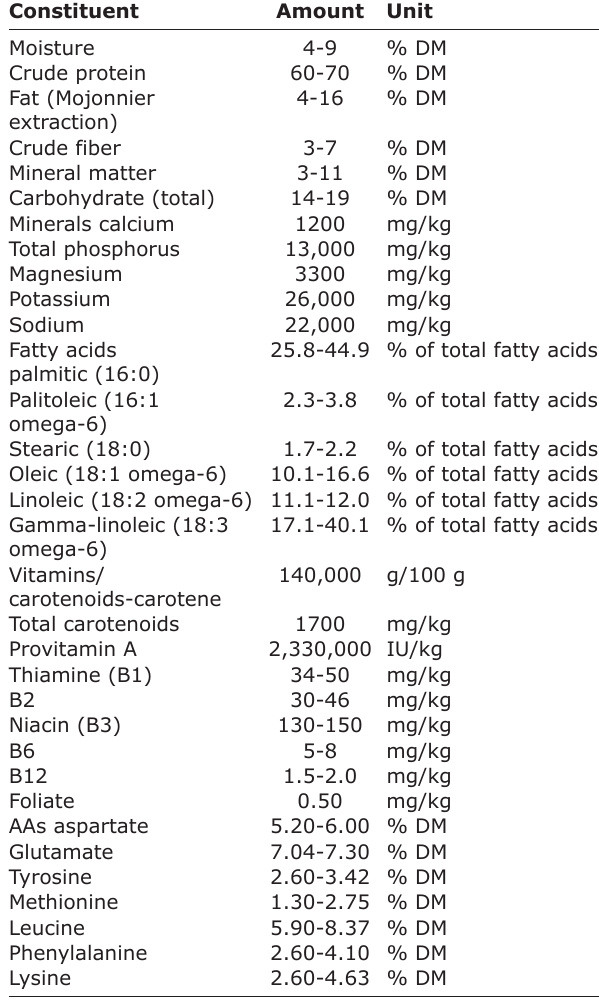
Table-1: Analytical chemical and nutritional composition of S. platensis a